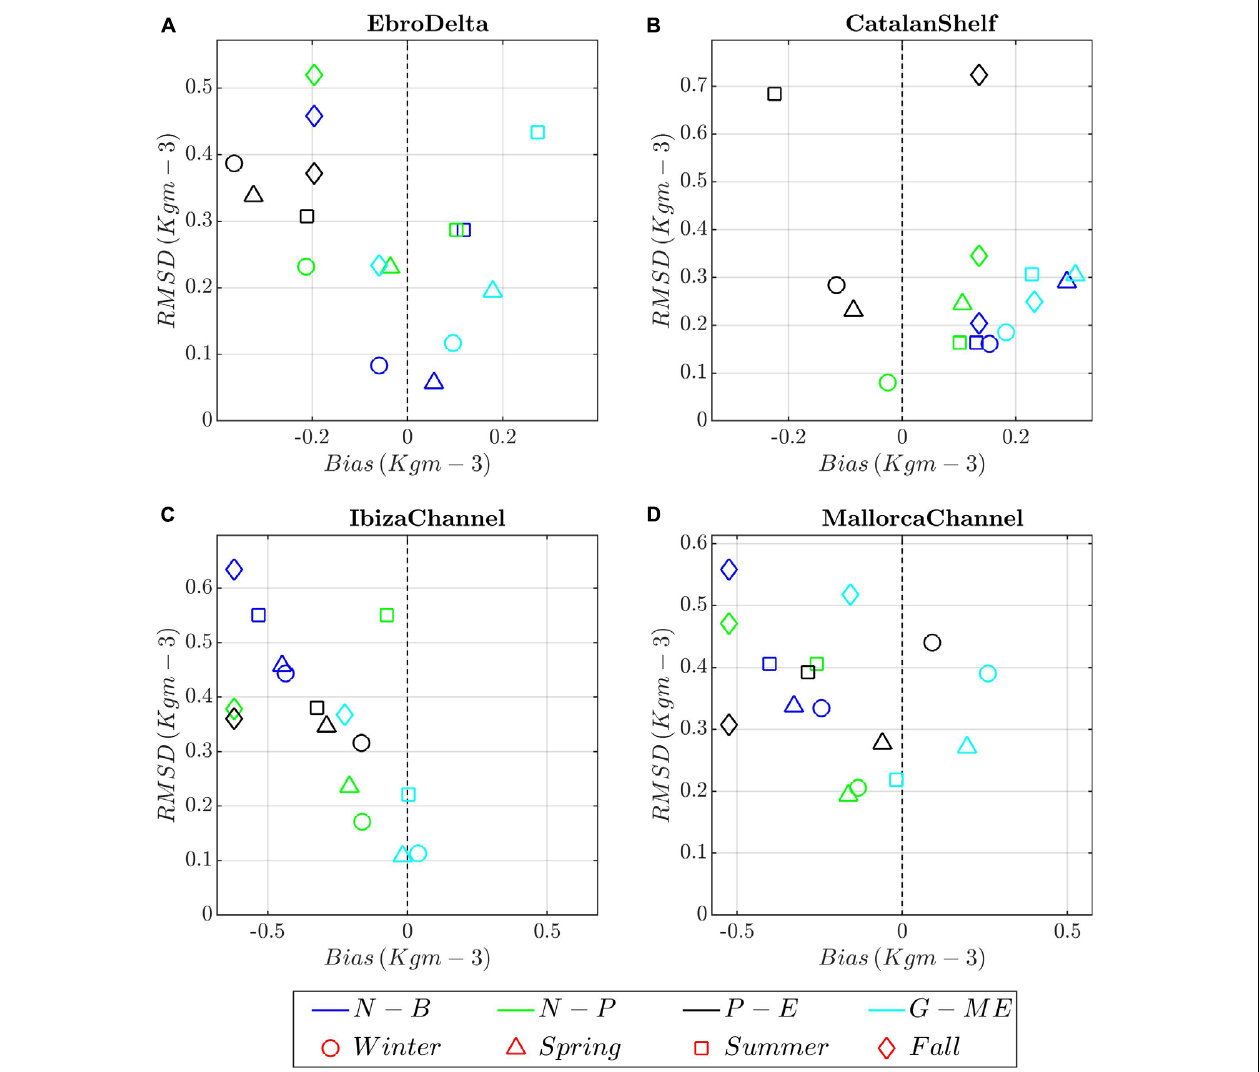
FIGURE 9 | Target diagrams between model runs (color shading) and climatological profiles of water density for the different seasons (symbols) and areas. (A) Ebro Delta; (B) Catalan Shelf, (C) Ibiza Channel, and (D) Mallorca Channel. Model runs: blue, N-B (NEMO-BFM); green, N-P (NEMO-PISCES), dark gray; P-E (POLCOMS-ERSEM), and light blue, G-E